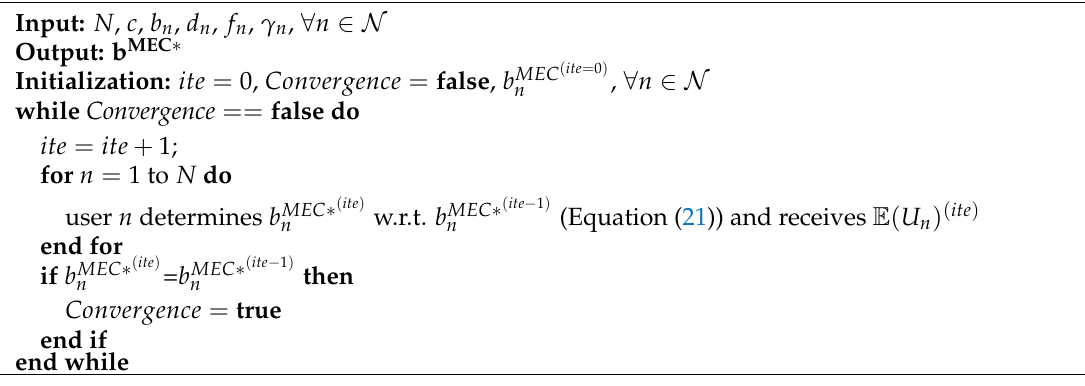
Algorithm 1 Pricing and risk-aware data offloading